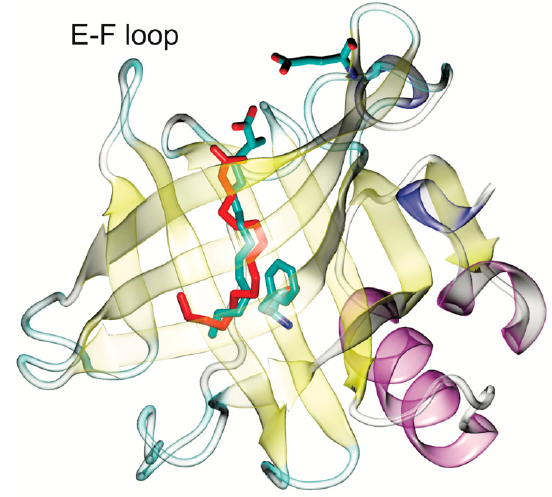
Figure 1. The β -lactoglobulin (BLG) monomer (from PDB-ID 1GXA) with its binding site or “calyx”, formed by eight stranded antiparallel β -sheets and occupied by its natural ligand, palmitate (in green from X-ray diffraction (XRD) and in red from docking). The position of the ligand can be reproduced by docking. Palmitate, and the residues at the bottom (F105) and mouth (E62) of the calyx (used in subsequent calculations), are shown in sticks.